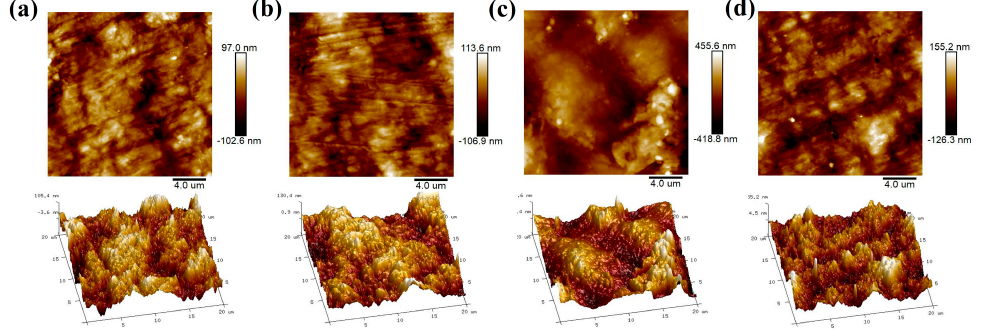
Figure 6. ( a ) The XPS survey scan of P(VDF ‐ CTFE) and the films treated under different conditions. ( b ) Carbon (C 1s) spectra of P(VDF ‐ CTFE) and the film treated at 10 kV for 15 s. ( c ) Oxygen (O 1s), fluorine (F 1s) and chlorine (Cl 2p) spectra of P(VDF ‐ CTFE) and the film treated at 10 kV for 15 s. Polymers 2020 , 12 , x FOR PEER REVIEW Table 2. The element content of P(VDF ‐ CTFE) and the films treated by DBD.